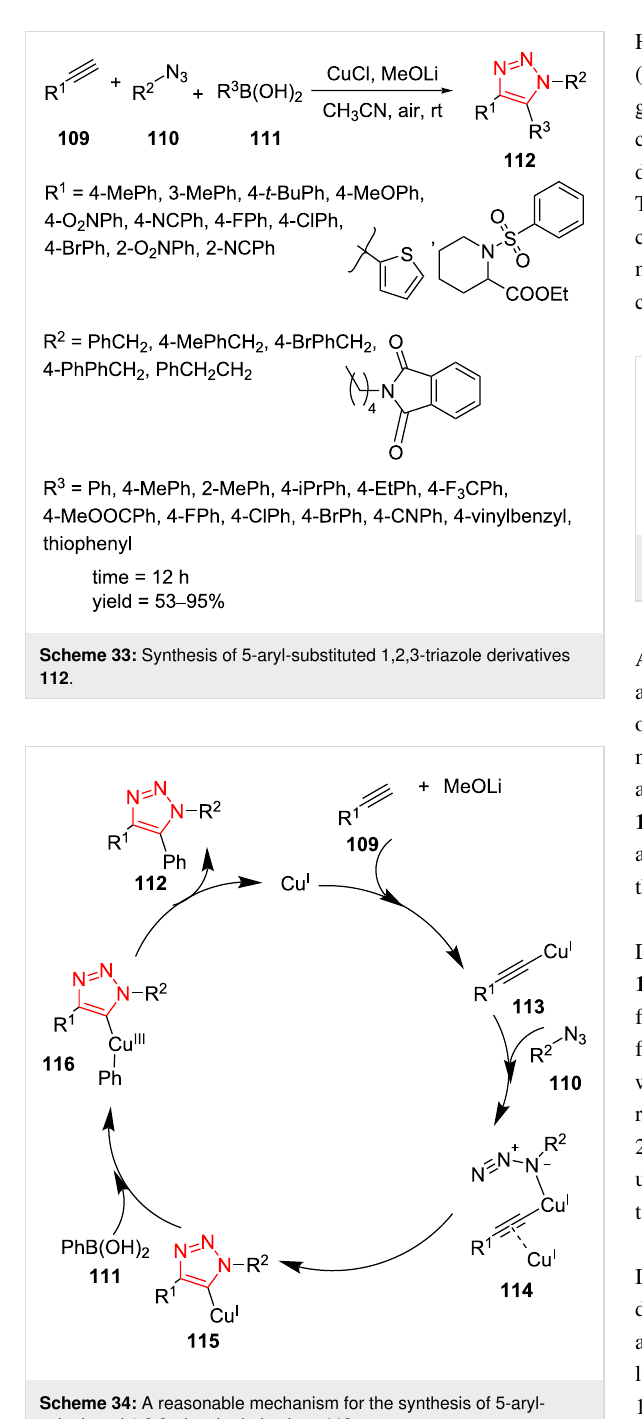
carboxamides 119 was introduced by Schwab et al. in